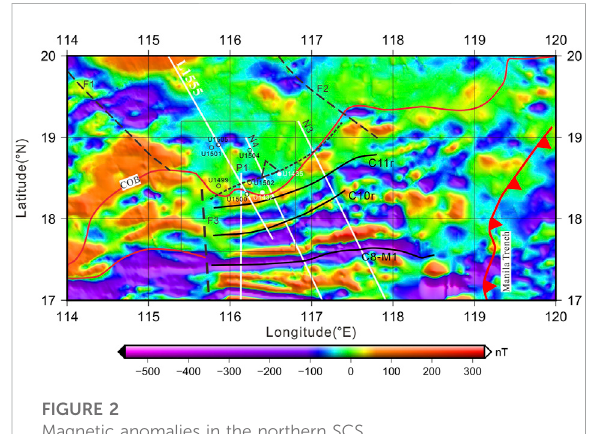
FIGURE 2 Magnetic anomalies in the northern SCS.